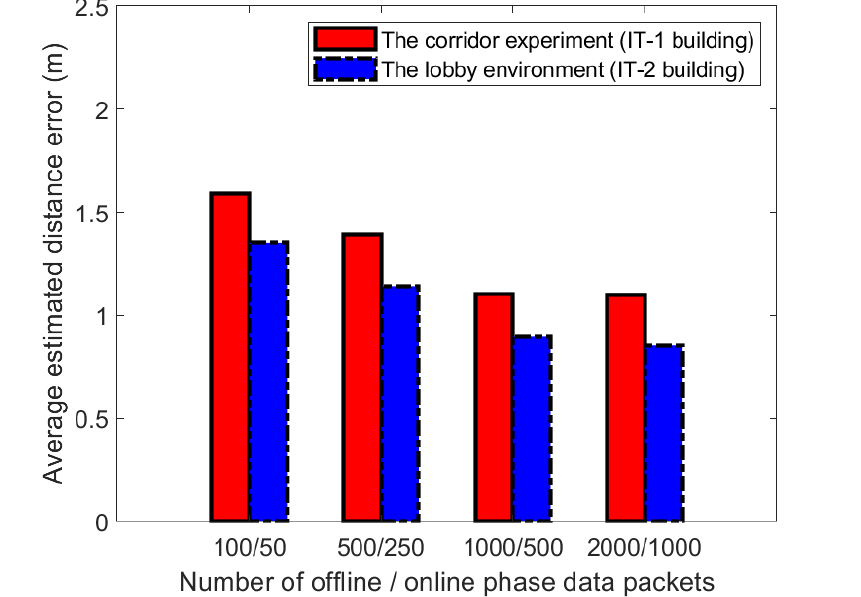
Figure 23. Distance estimation errors at reference points (4,2) in two different experimental environ-